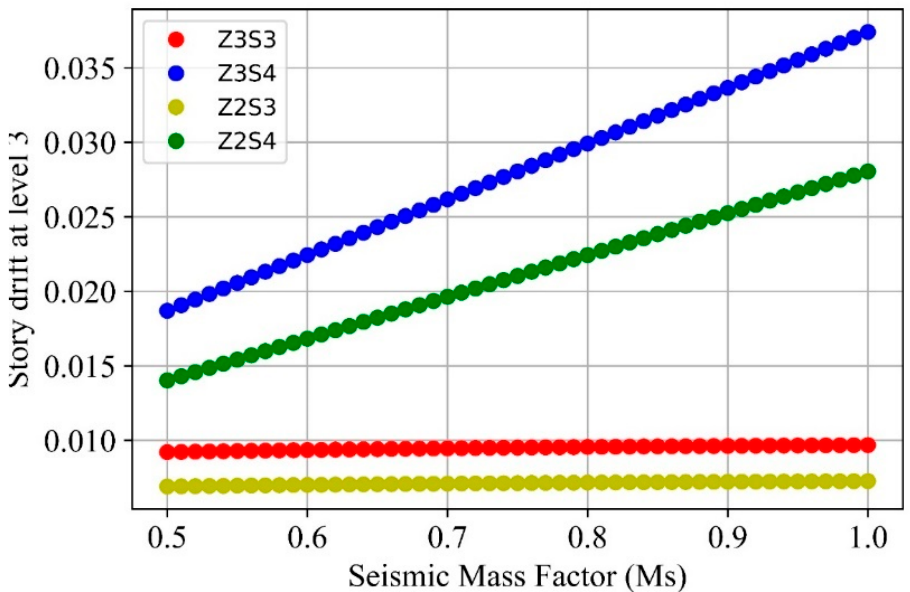
Figure 18. Variation of seismic mass factor (Ms) vs. drift at level